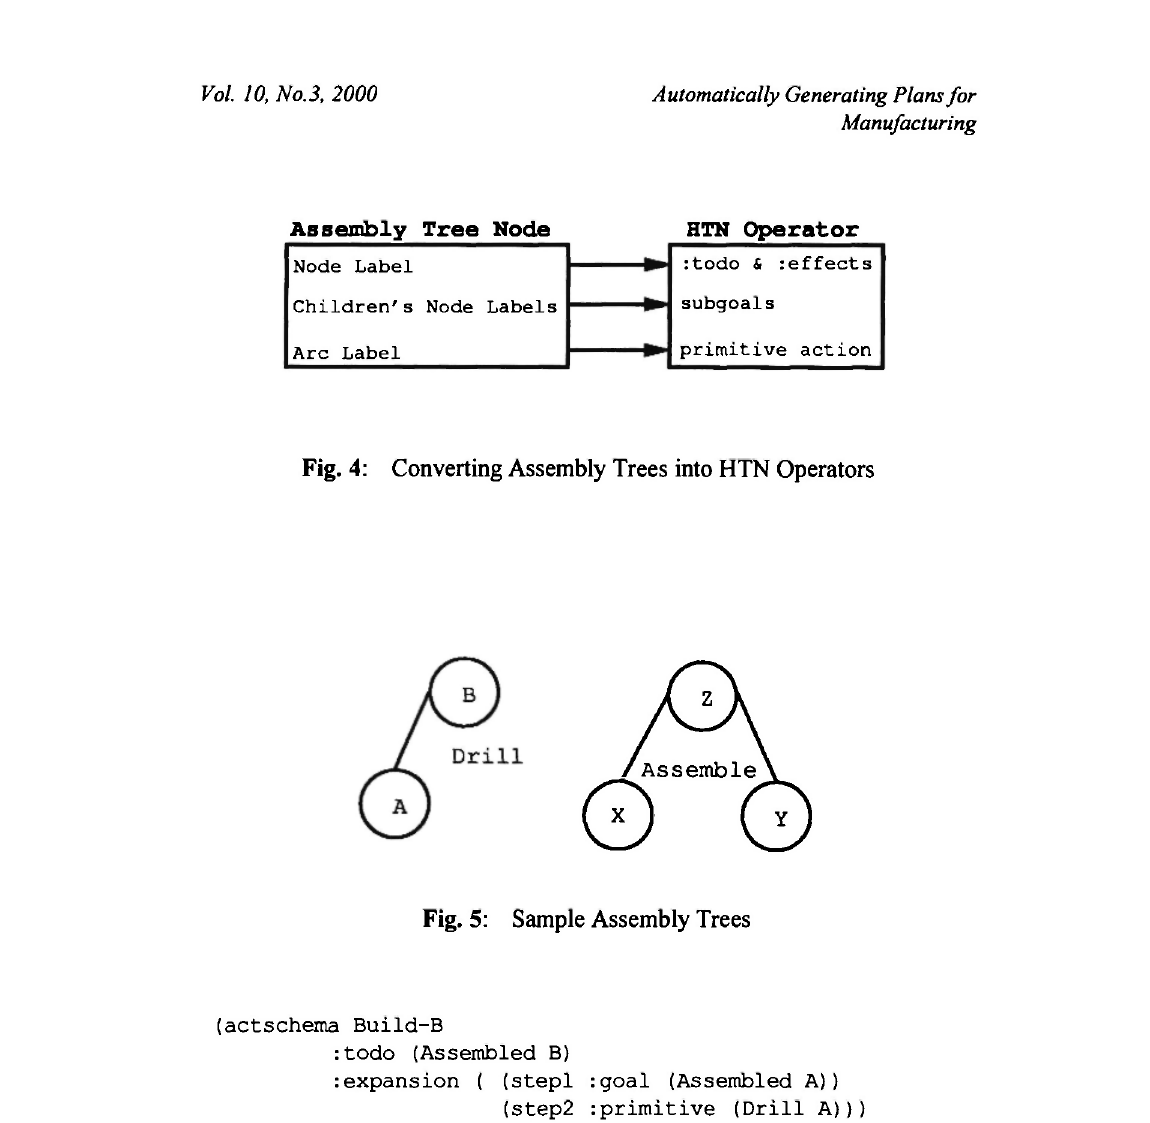
Fig. 5: Sample Assembly Trees